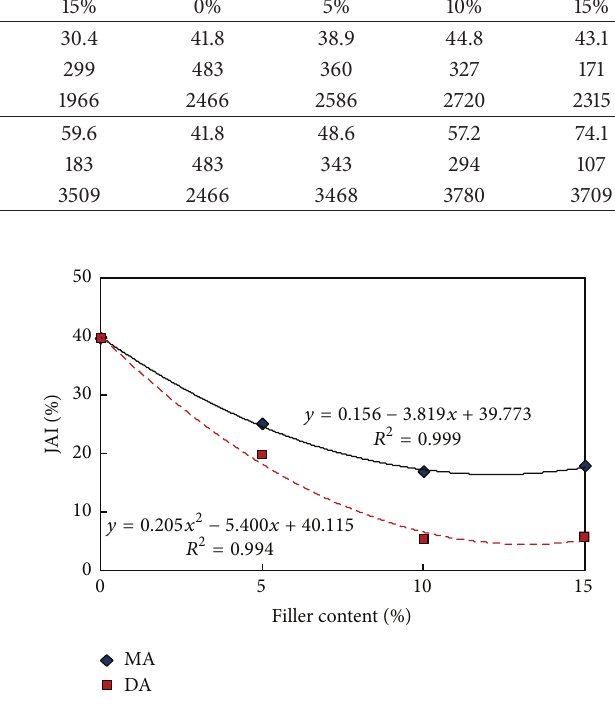
Figure 8: DRRs of asphalt mastics versus content after TFOT. Figure 9: JAIs of asphalt mastics versus content after